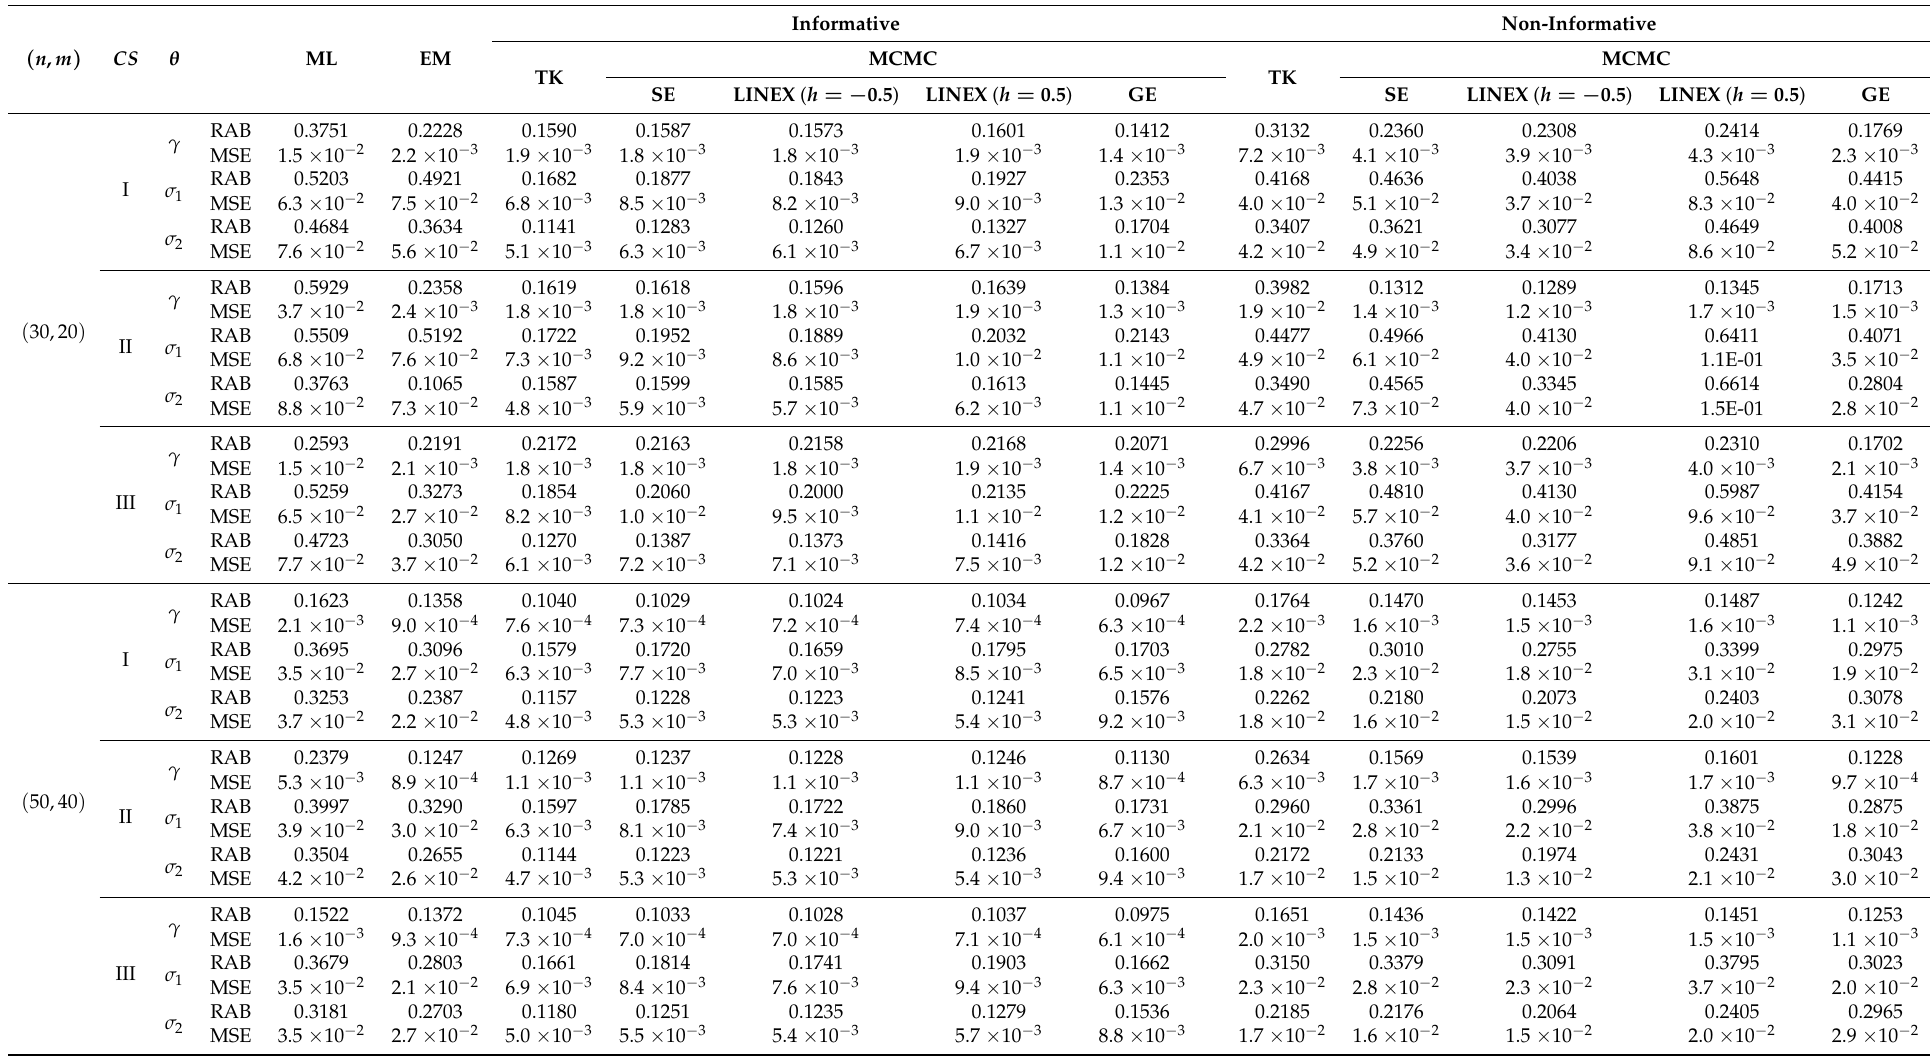
Table 8. Values of RAB and MSE for the classical and Bayesian estimation of distribution